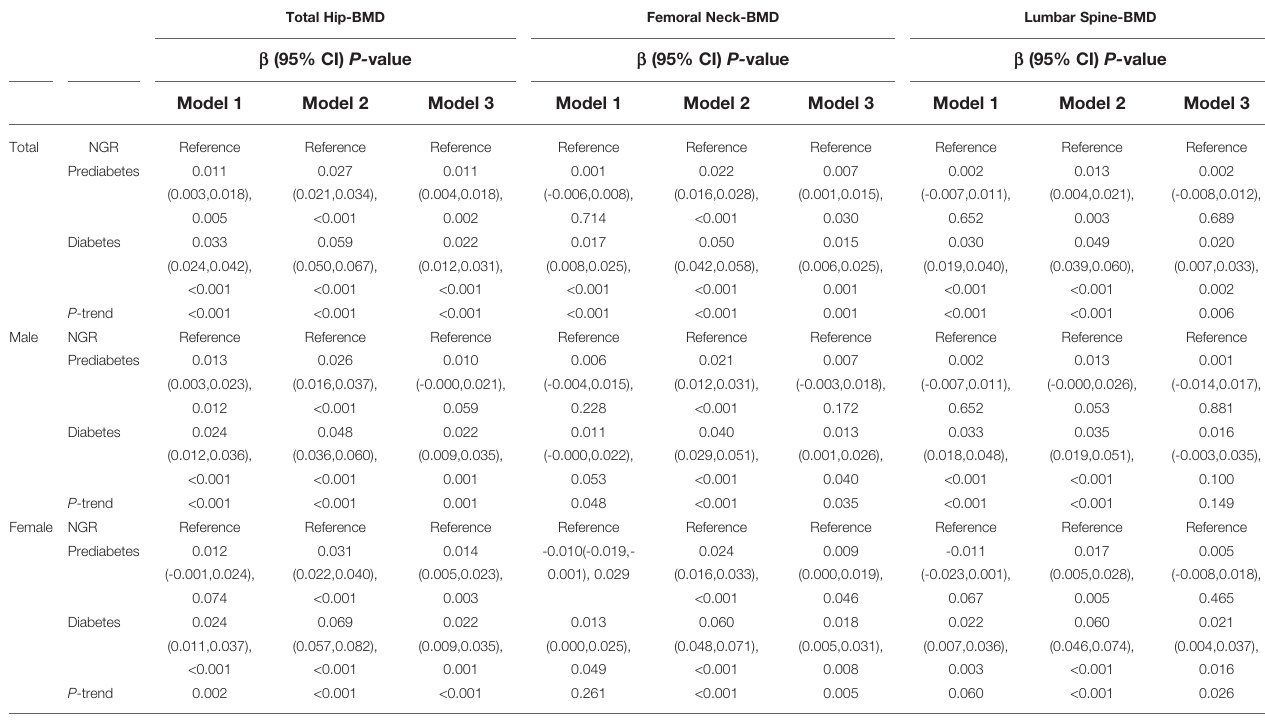
TABLE 2 | Associations between glucometabolic status and BMD values